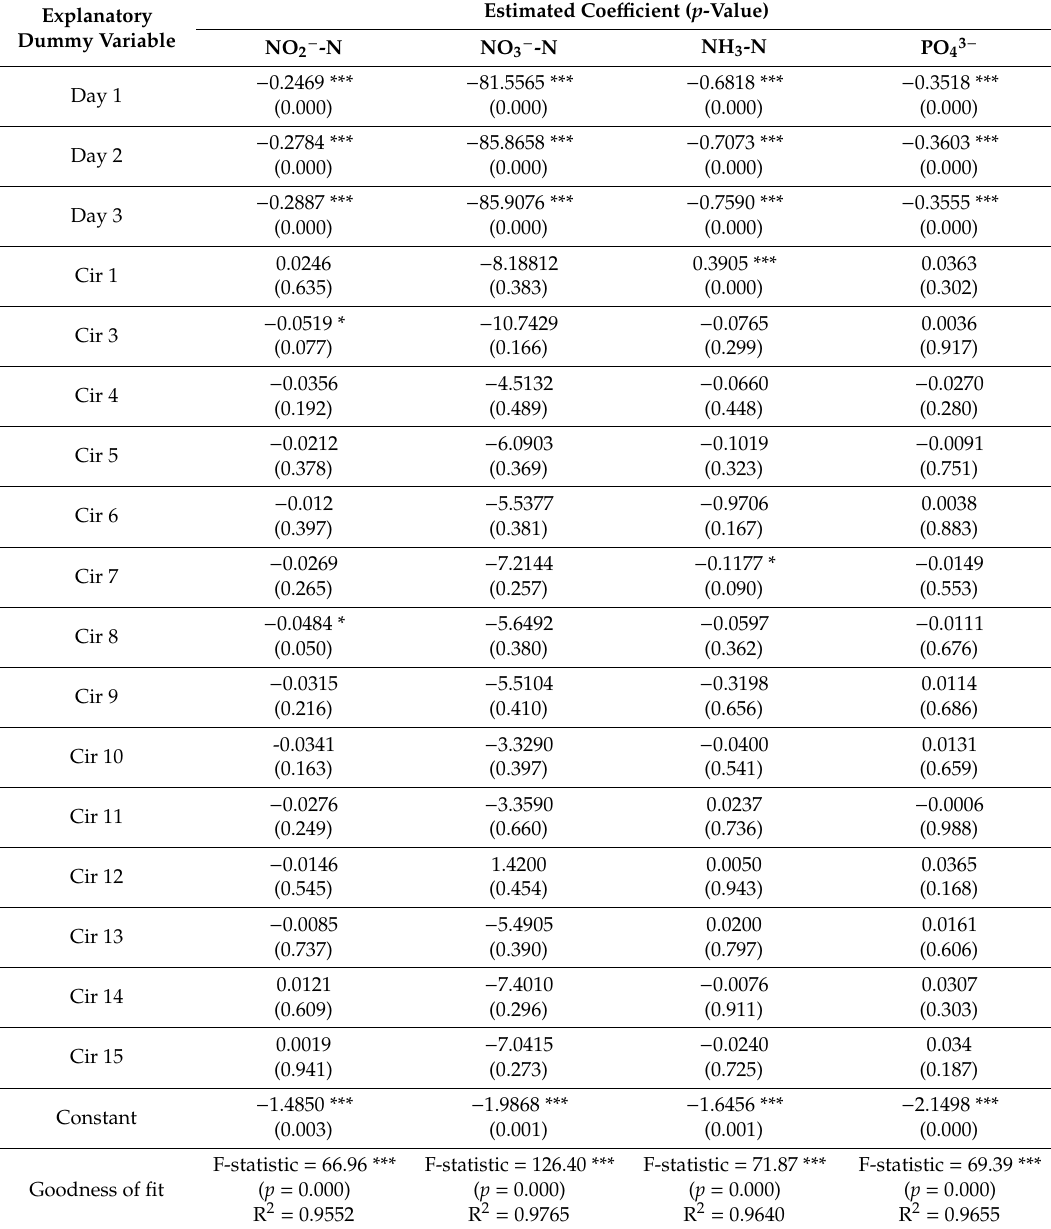
Table 1. Multiple linear regression results for the e ff ects of the integrated circulation system on nutrient concentration (n = 60 = 4 days × 15